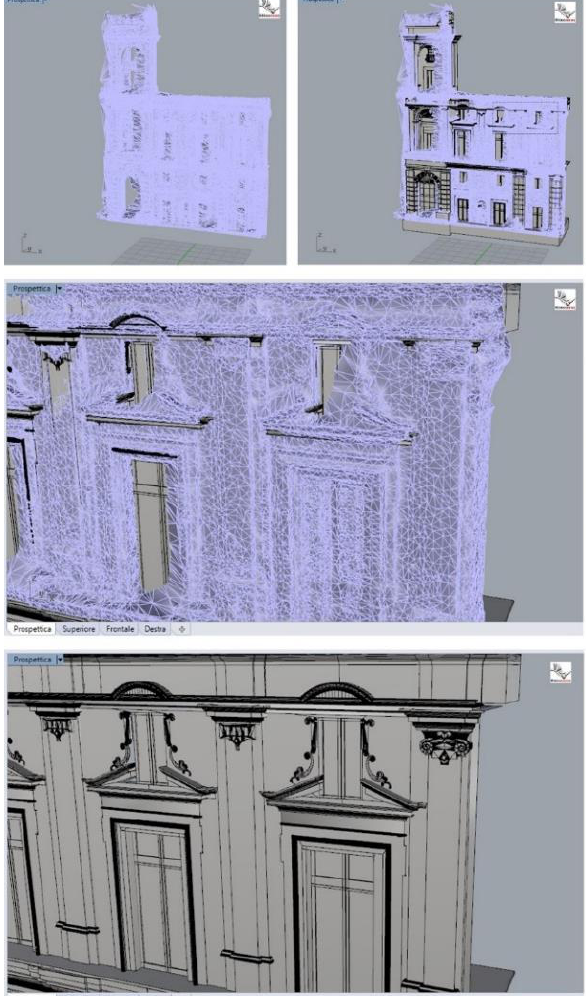
Figure 6. Polygonal model (mesh) and NURBS model in adherence to the mesh, in Rhinoceros (above); Detail of the decorative elements in NURBS model